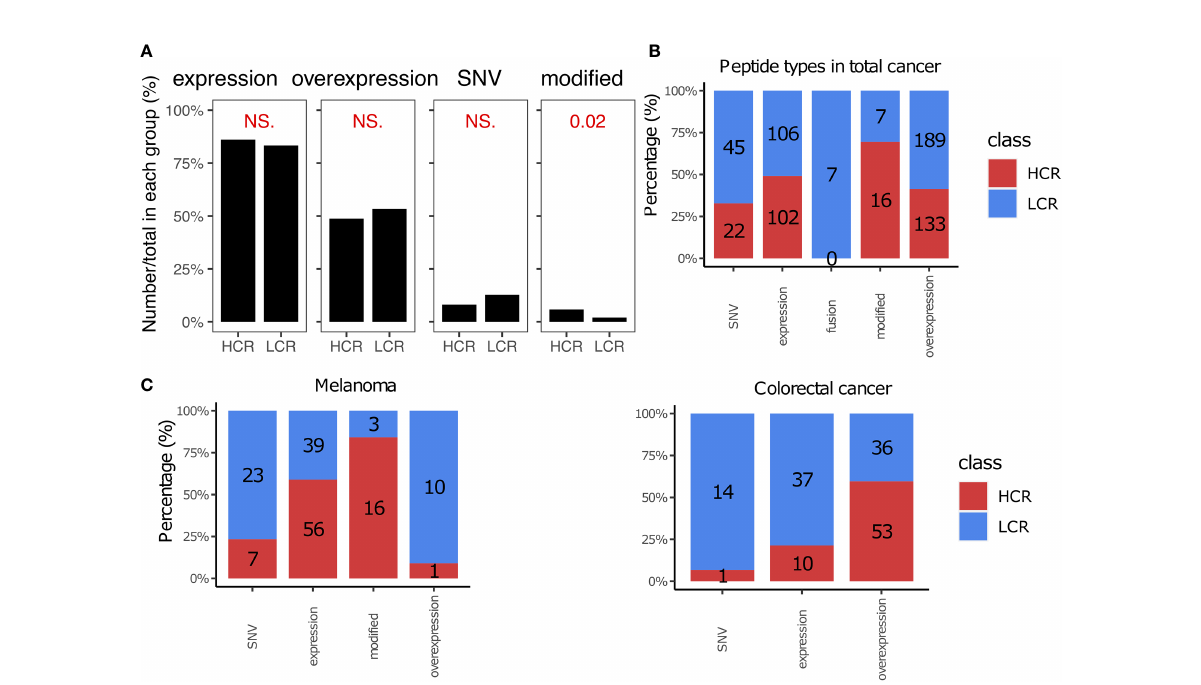
FIGURE 3 Peptide types in high and low clinical response results. (A) Comparison of peptide types between high clinical response (HCR) results and low clinical response (LCR) results. The distribution of peptide types in HCR and LCR results. (B) The distribution of peptide types in HCR and LCR results. (C) The distribution of peptide types in HCR and LCR results in melanoma and colorectal cancer, respectively. P-values were calculated using two-sided Wilcoxon rank-sum tests. NS., not signi fi